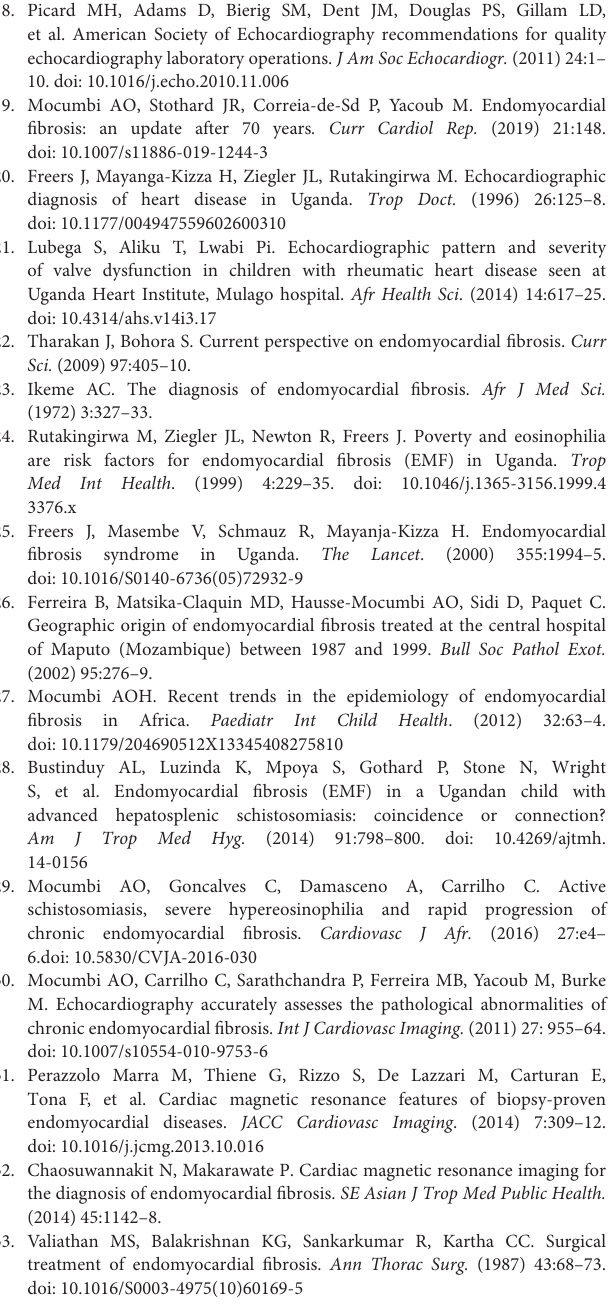
Supplementary Table 1 | Showing trends in the numbers, mean and median ages, and incidence rates of new EMF diagnosis seen at the Uganda Heart institute, alongside Uganda’s GDP per capita and Under-5 mortality